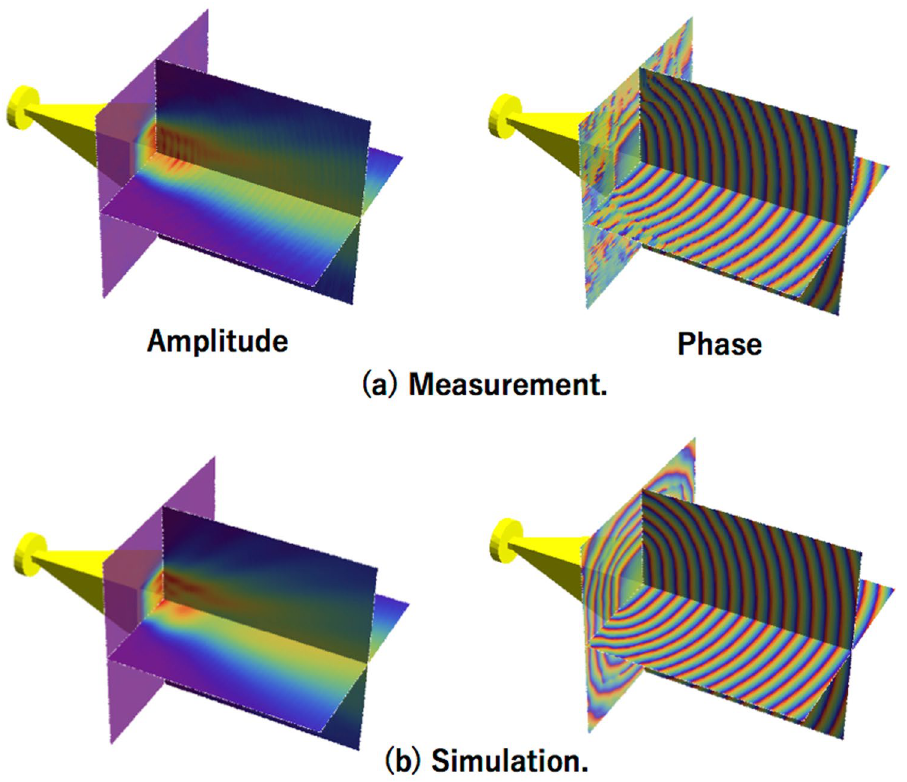
Figure 4. Amplitude and phase distribution of the mm-wave emitted by a horn antenna. The signal source is a free-running Gunn oscillator. ( a ) Measured results and ( b ) simulated results. Note: The pyramidal horn antennas are simulation models.